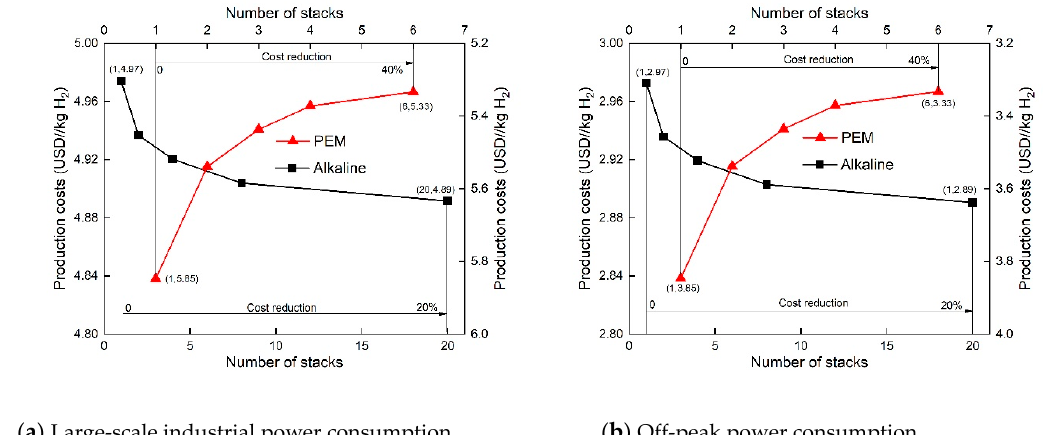
Figure 5. Trends in the cost of electrolyzers in multi-stack systems.